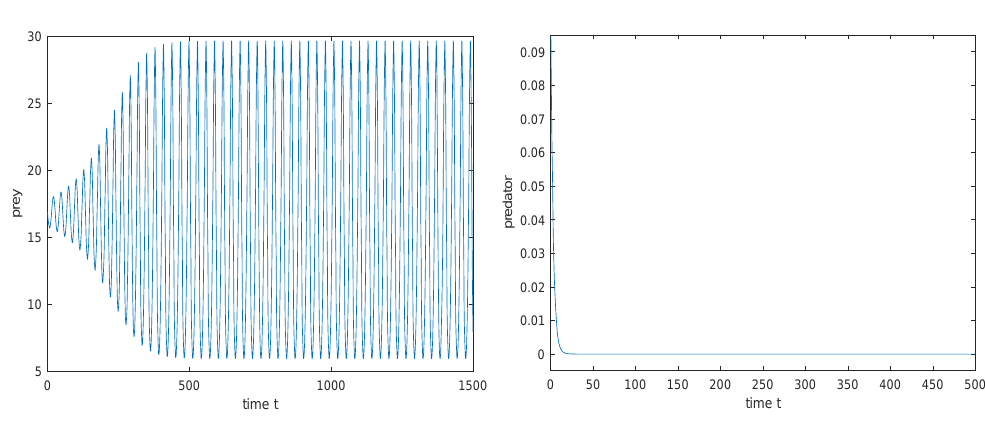
Figure 15. τ = 6 ∈ ( τ ∗ , ∞ ) = ( 5.5939, ∞ ) , E 2 is unstable, a periodic boundary solution ( u ( t ) ,0 ) is bifurcated from E 2 . Initial value: ( φ 1 , φ 2 ) = ( 16.9,0.1 )